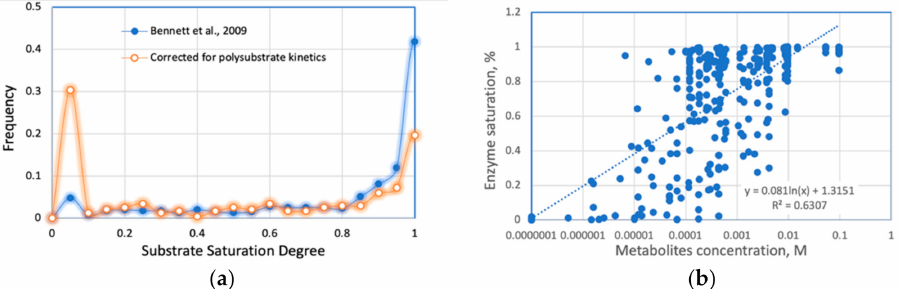
Figure A2. Experimental data on metabolite concentrations and implied enzyme active site occupancy in Escherichia coli. Replotted from the supplemental data of Reference [145]. ( a ) Frequency distribution of enzyme substrate saturation before (blue) and after correction (orange) according to Equation (A15). ( b ) The plot of substrate saturation vs. log-scale metabolite